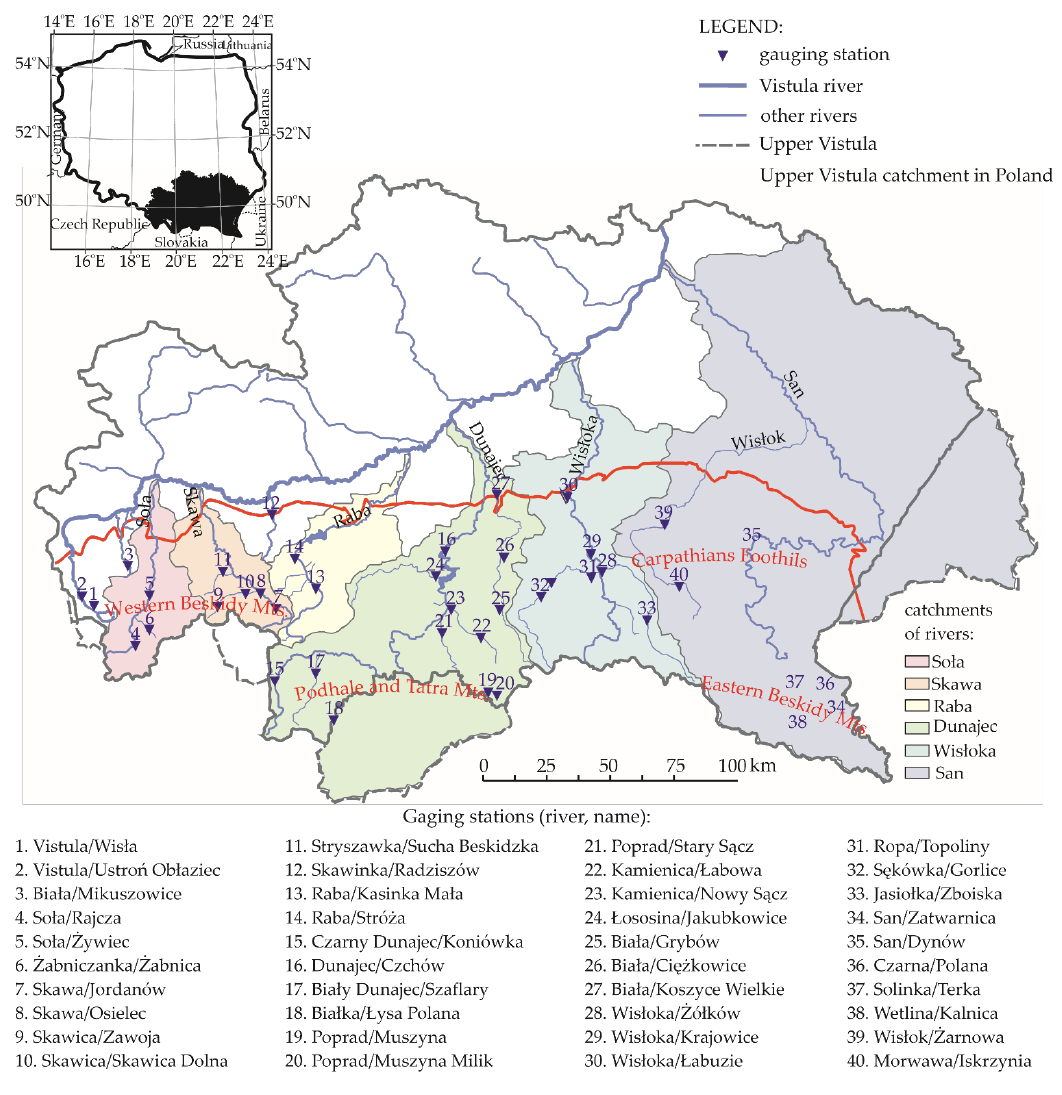
Figure 1. Study area and location of water gauging